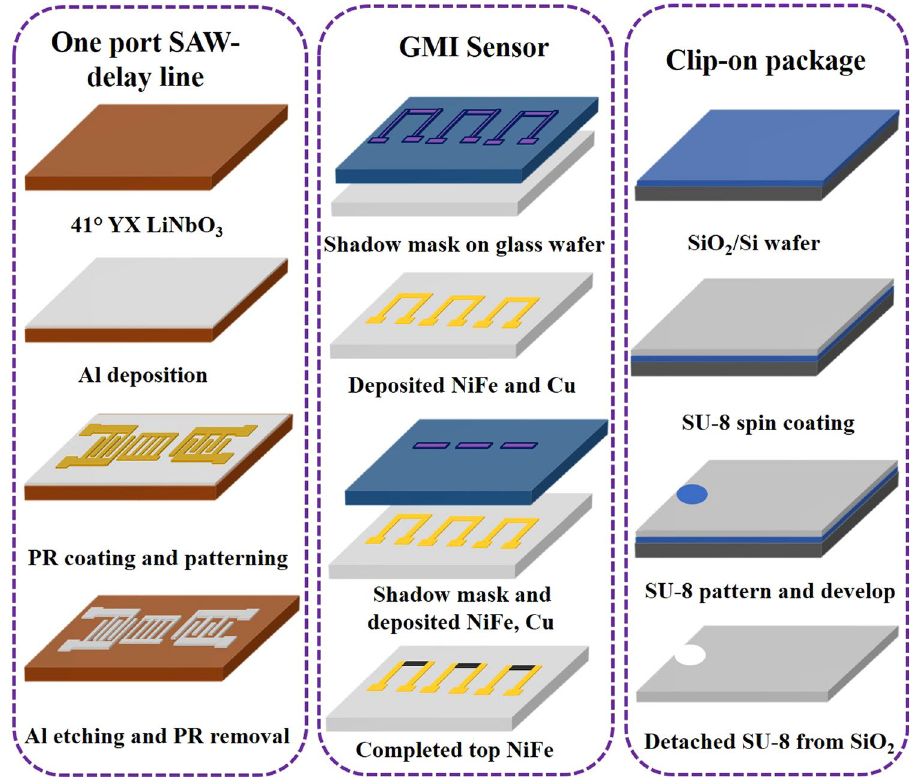
Figure 8. Schematic views of the fabrication procedures for one-port SAW reflective delay line, GMI sensor, and clip-on packaging